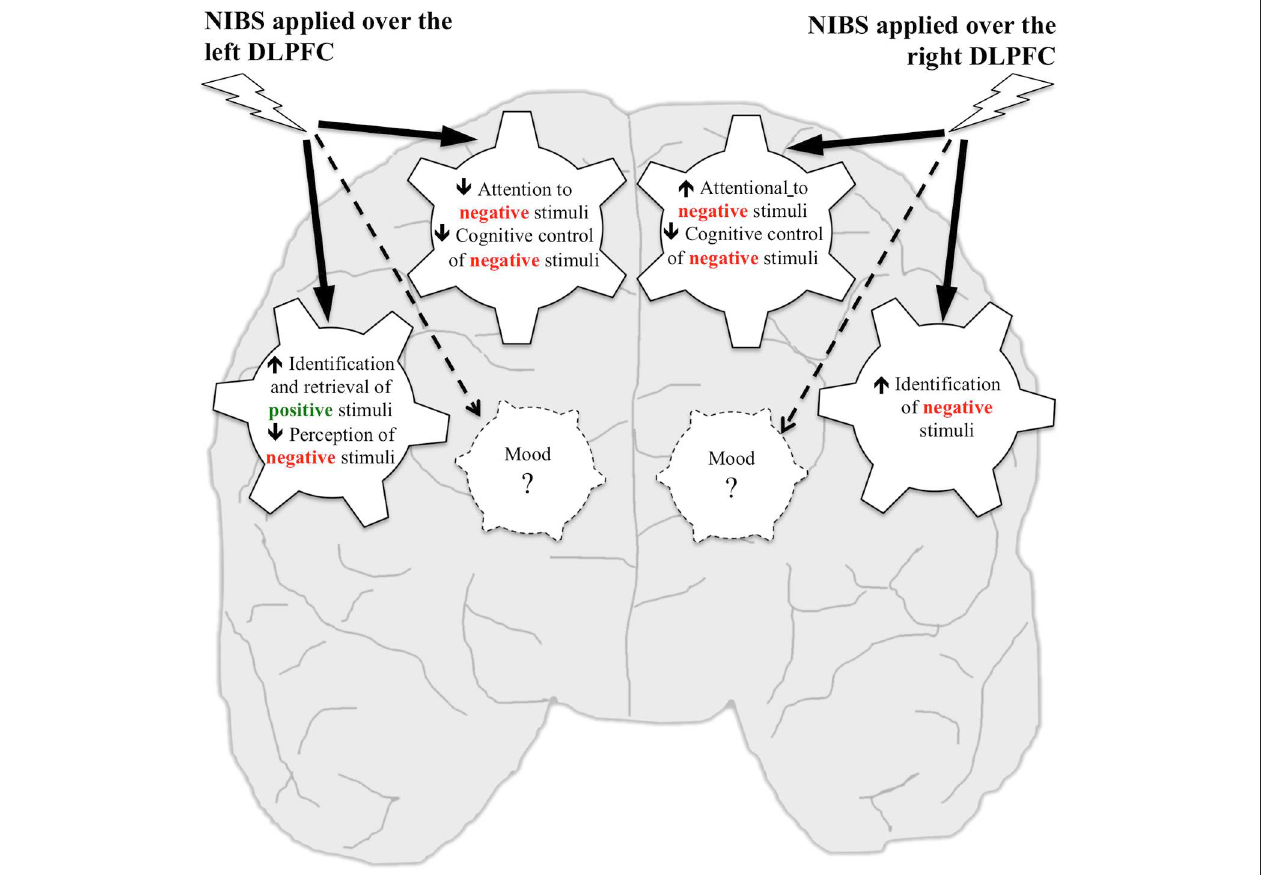
FIGURE 1 | Putative effects of NIBS over the left and right DLPFC on mood, emotional processing, and attentional processing of emotional information in healthy individuals. Wheels represent processes that have been targeted using NIBS. Studies reported that NIBS applied over the left DLPFC increased identification and retrieval of positive stimuli, decreased perception of negative stimuli, decreased attention to negative stimuli, and cognitive control of negative stimuli, but no effect was reported on mood. NIBS applied over the right DLPFC increased identification of negative stimuli, increased attention to negative stimuli and decreased cognitive control of negative stimuli, but no effect was reported on